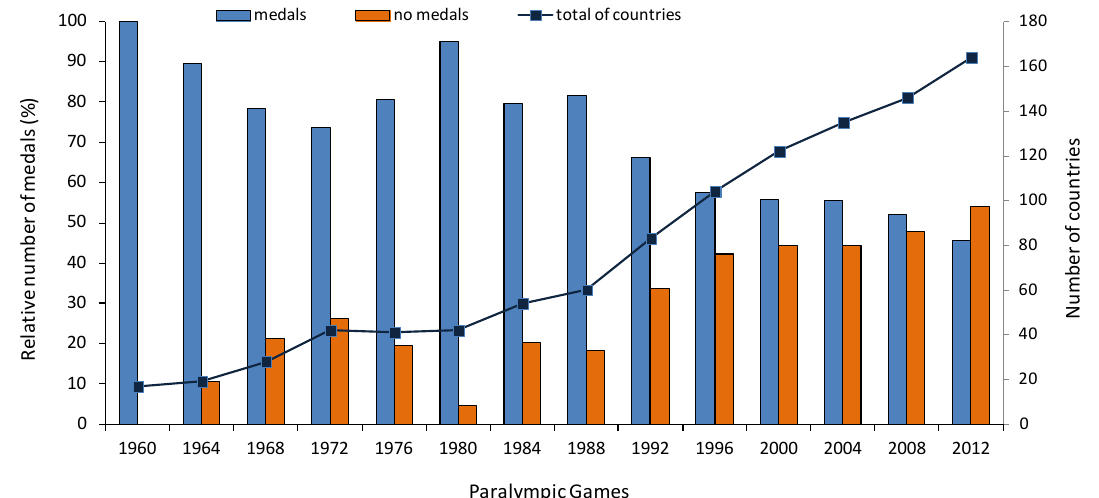
Figure 3. Contrast between countries that have participated in the Paralympic Games since 1960 that have won medals and countries that have won no medals 9